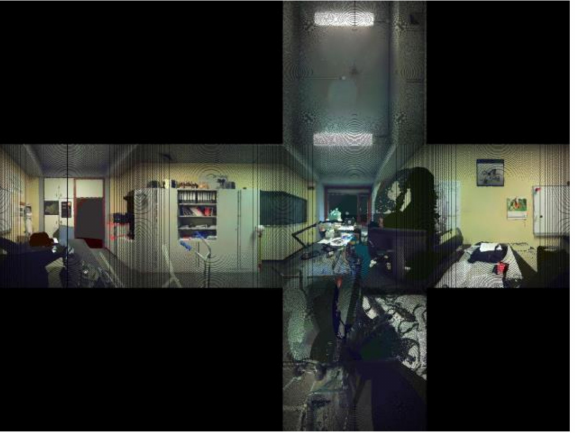
Figure 10. The resulting cubemap of the direct